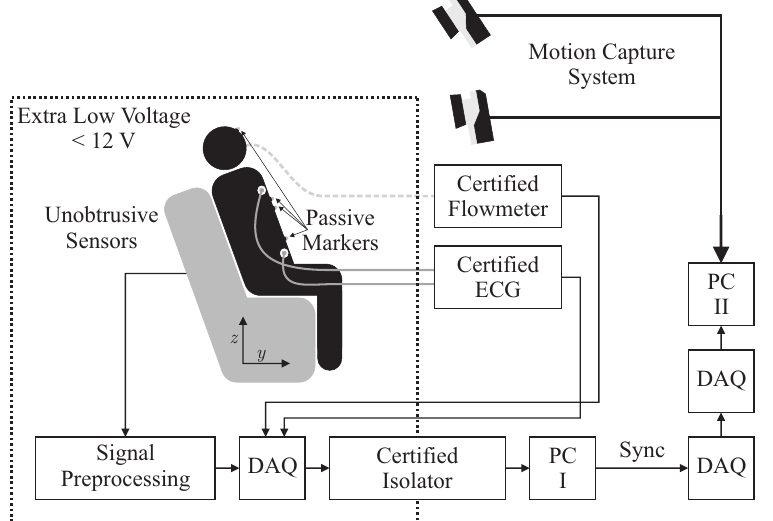
Figure 1. Overall measurement setup. The test subject is only connected to certified reference sensors and unobtrusive sensors that are isolated using certified power supplies and